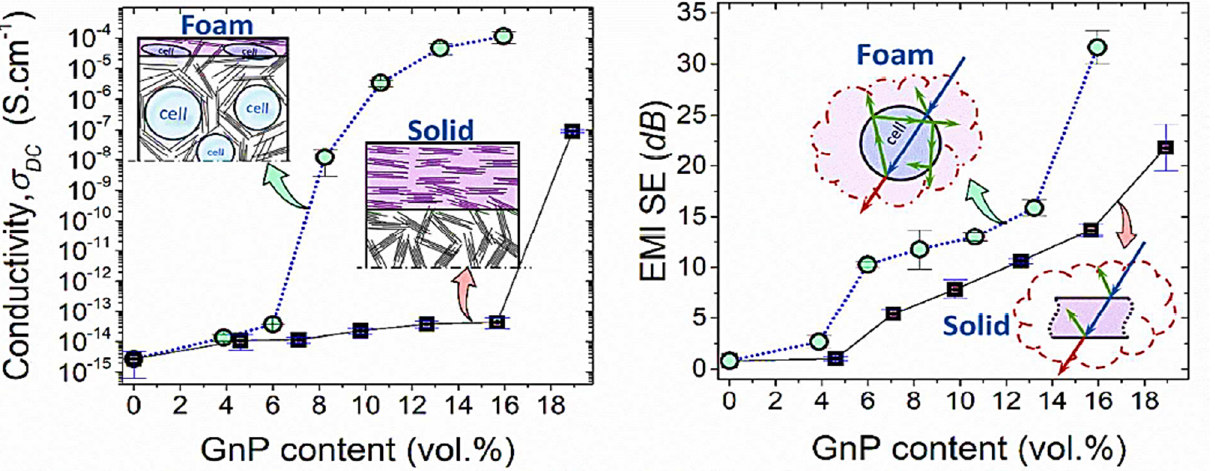
Figure 5. Variation of the electrical conductivity and the EMI SE value in solid and foamed HDPE-GnP composites. Reproduced with permission from [99]. Copyright 2018, American Chemical Society.